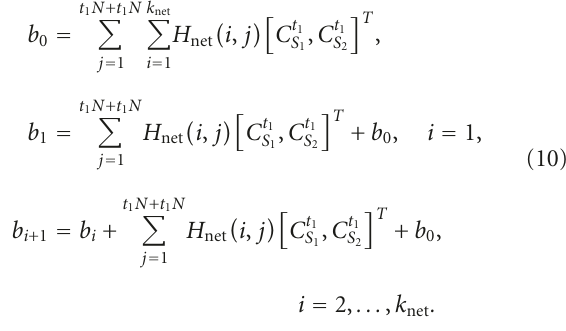
Figure 5: The achievable sum-rate with P t 1 1 + P t 1 2 ≤ P t 1